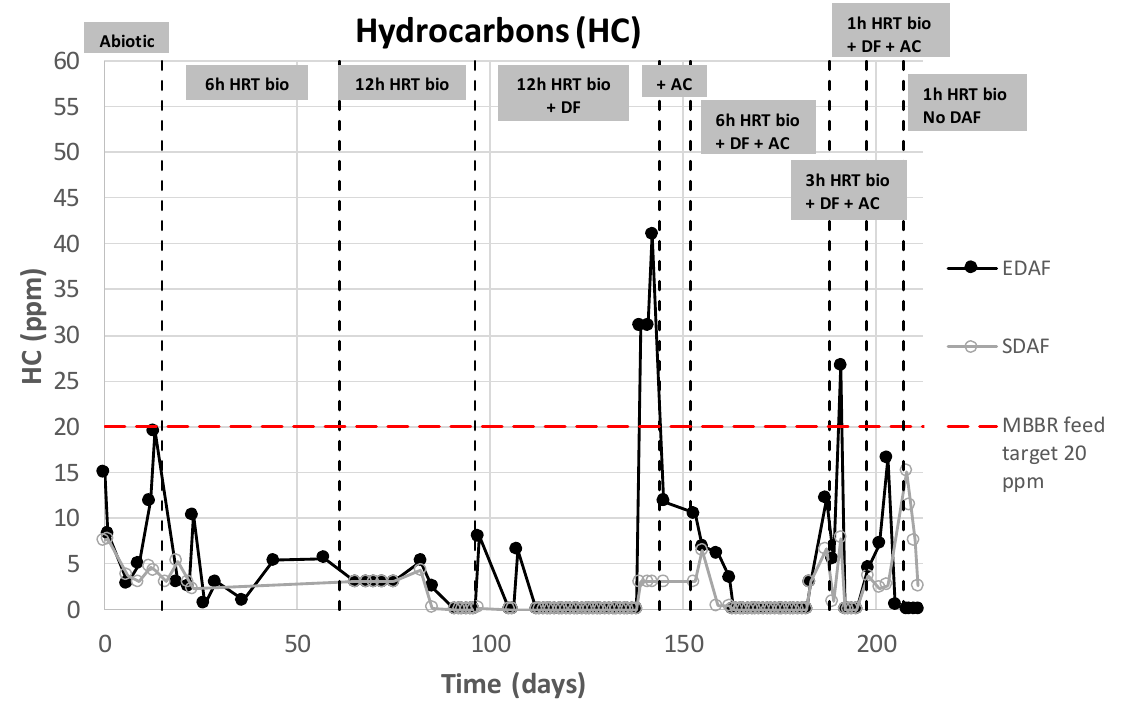
Figure 7. Dispersed hydrocarbon removal efficiency by DAF.EDAF (DAF inlet), SDAF (DAF outlet), MBBR (Moving Bed Bioreactor), HRT (Hydraulic Retention time), DF (Disk Filter), AC (Activated Carbon Filter).